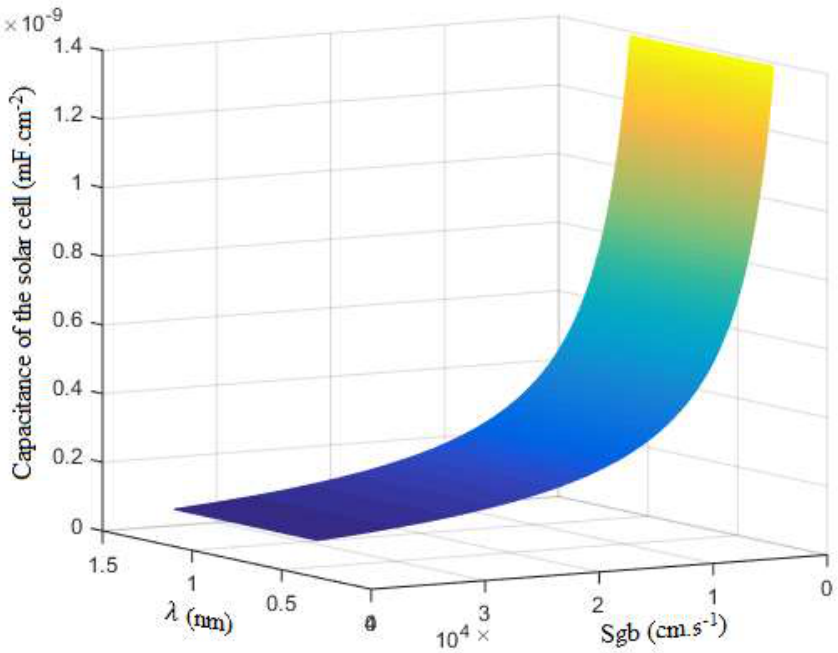
Figure 6. Capacitance of the illuminated illuminated solar cell by the front surface according to the grain boundary recombination solar cell by the front surface according to the grain boundary velocity (Sgb) and wavelength (λ): Sb = 10 velocity (Sgb) and wavelength (λ): Sb = 10 4 cm.s -1 , L = 0.01 cm, H=130 µm and R = 0.01 cm